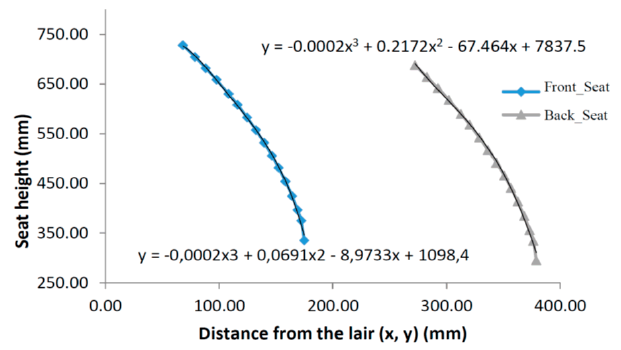
Figure 6. Optimization of the mechanism geometry with the trajectory. Machines 2017 , 5 , 23